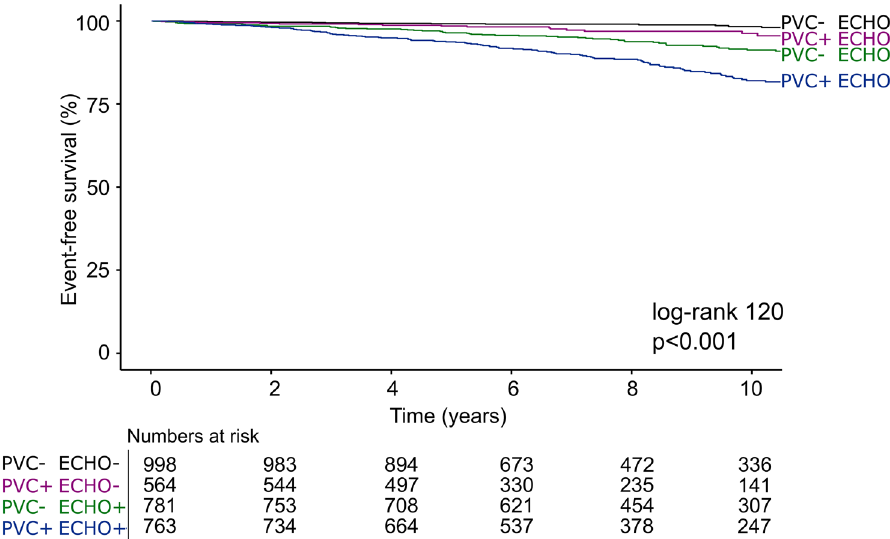
Figure 2. Time-to-event analysis for the combination of PVCs during recovery and abnormalities on echocardiography among 3106 patients experiencing 219 cardiovascular mortality events during 7.9 [5.4–11.1] years of follow-up. ECHO− no significant abnormality on echocardiography, ECHO+ significant abnormality on echocardiography, PVC premature ventricular contractions, PVC− < 1 PVC/min during recovery, PVC+ ≥ 1 PVC/min during recovery. An echocardiographic abnormality was defined as either: reduced left ventricular ejection fraction, at least moderate valvular heart disease, left ventricular dilatation, increased left ventricular mass, or increased left ventricular filling pressures.